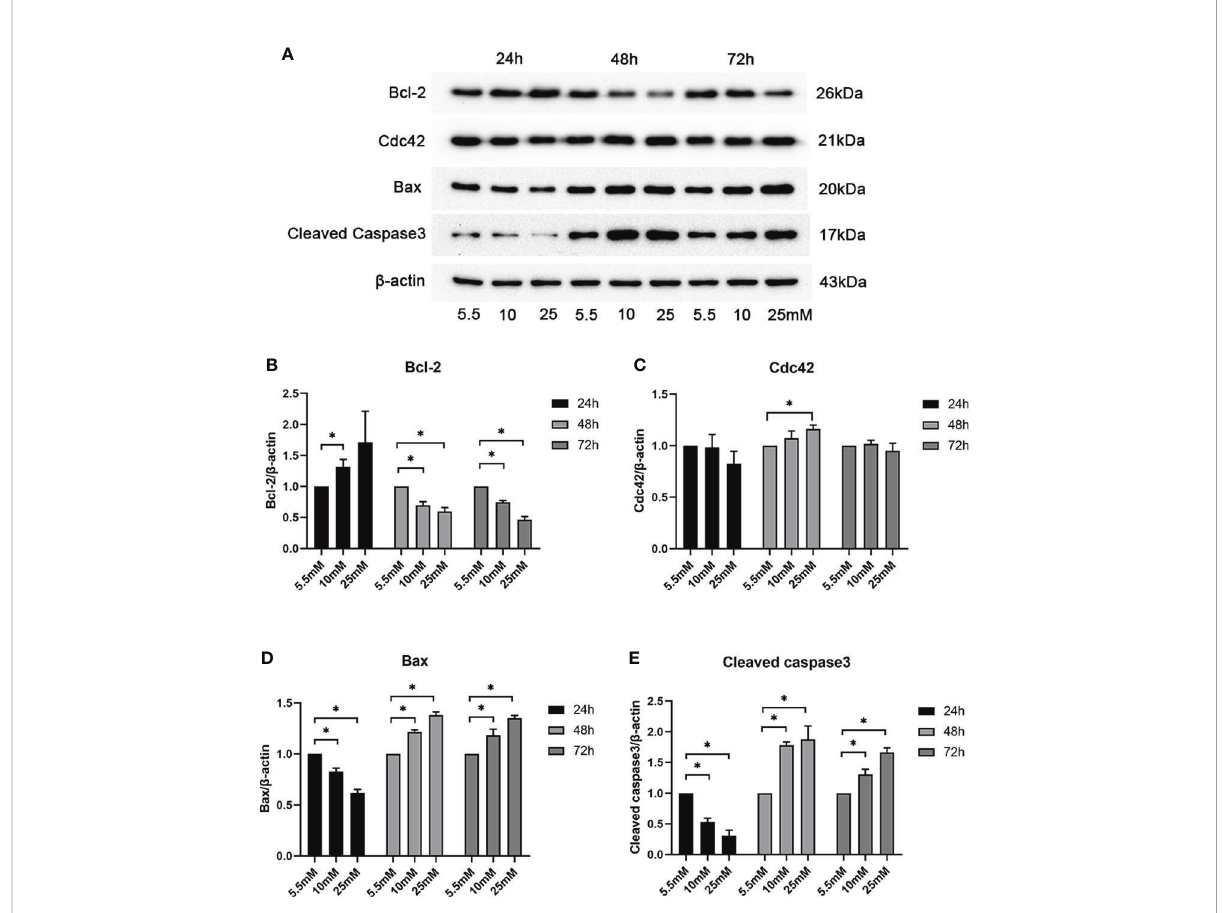
FIGURE 1 Examination of Cdc42 and Bax when treated with various glucose concentrations at different timepoints. ( A – E ) The protein expression levels of Cdc42, Bax, and cleaved caspase-3 increased, while those of Bcl-2 decreased, when treated with 25 mM glucose for 48 h. Data are presented as mean ± SEM; * P <